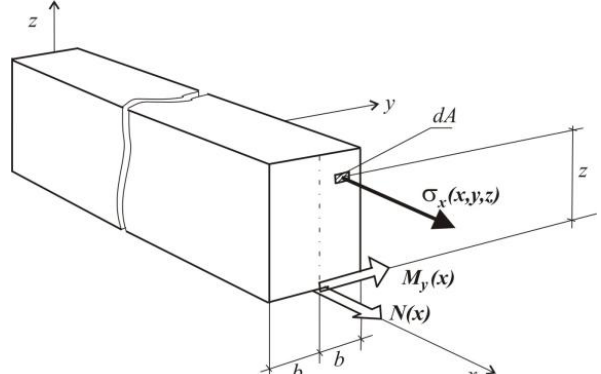
Figure 6. Scheme of rod subjected to mechanical and thermal loads